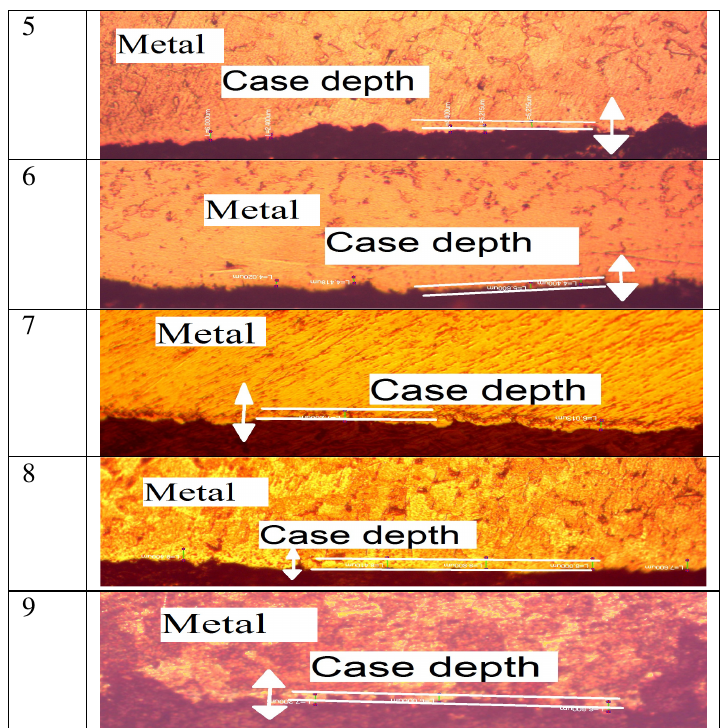
Fig. 4. Microstructures and penetration depth of carburized specimens according to (Taguchi) array